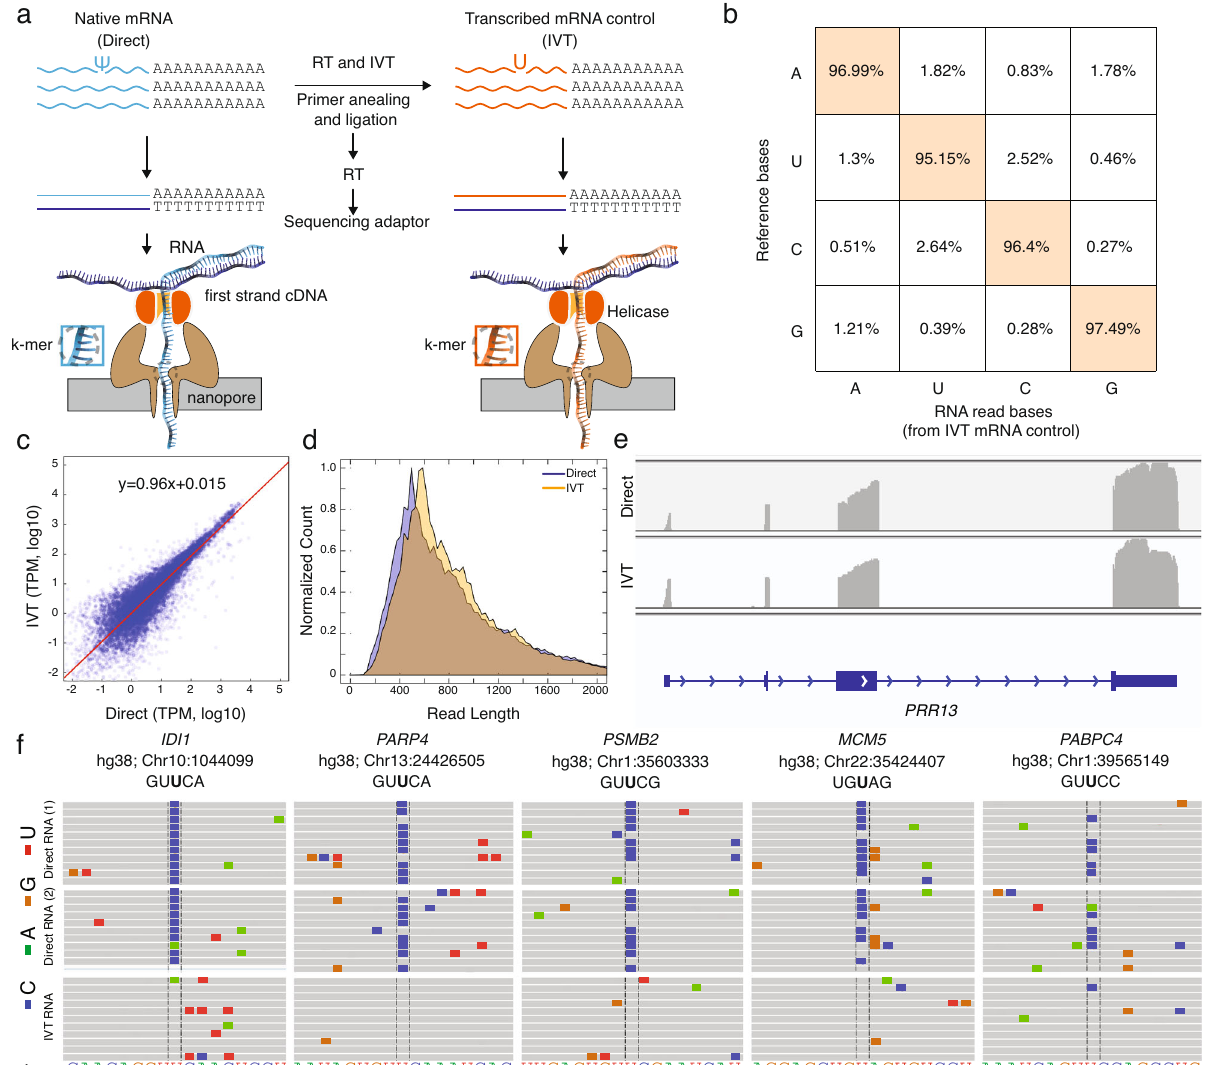
Fig. 1 | Nanopore native poly(A) RNA sequencing pipeline to identify ψ - modi fi ed sites. a Library preparation for Nanopore sequencing of native poly(A)- containing mRNAs (direct) and sequencing of in vitro transcribed (IVT) control. b The accuracyofcalled bases ofinvitrotranscribed(IVT) control samples.The x - axis shows called bases from nanopore reads and the y -axis is the base identity from the reference sequence at the same position that the nanopore reads are alignedto. c log 10 (TPM)ofdirectversusthelog 10 (TPM)ofIVT. d Normalizedcount